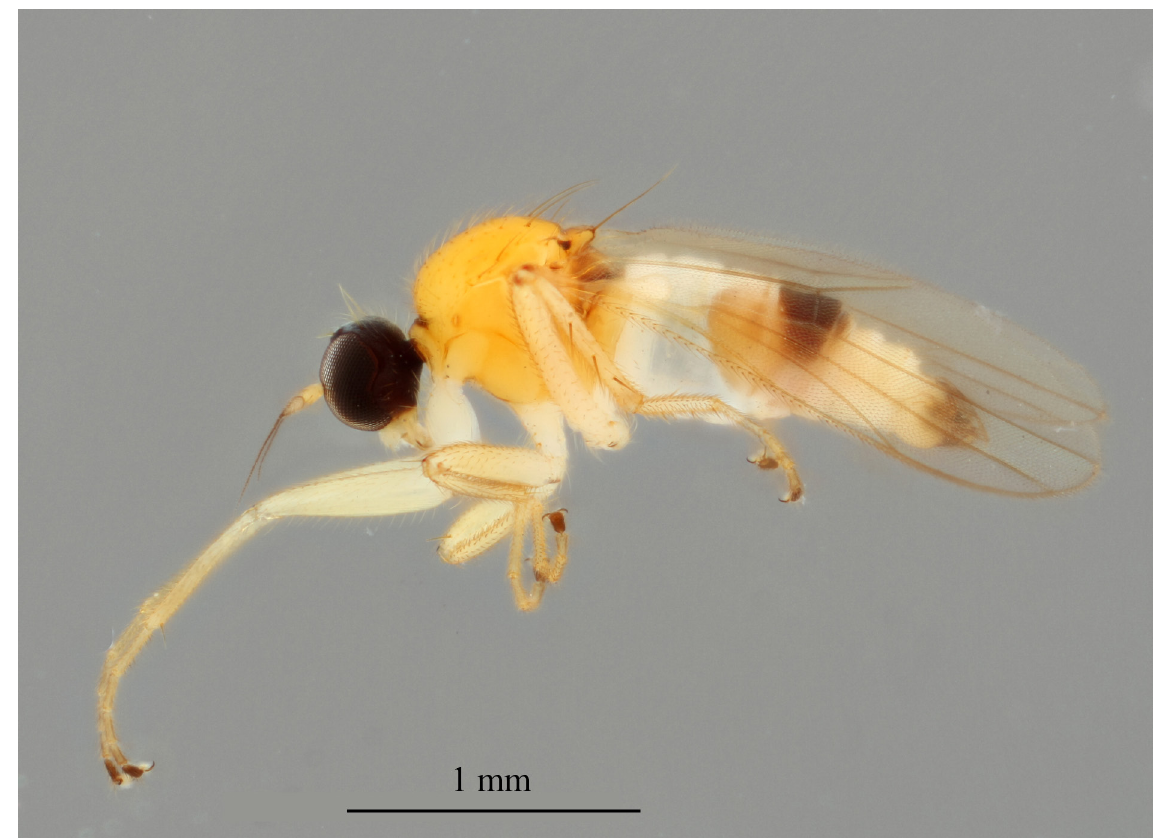
Fig. 1. Elaphropeza triseta sp. nov. Male habitus (photo J.